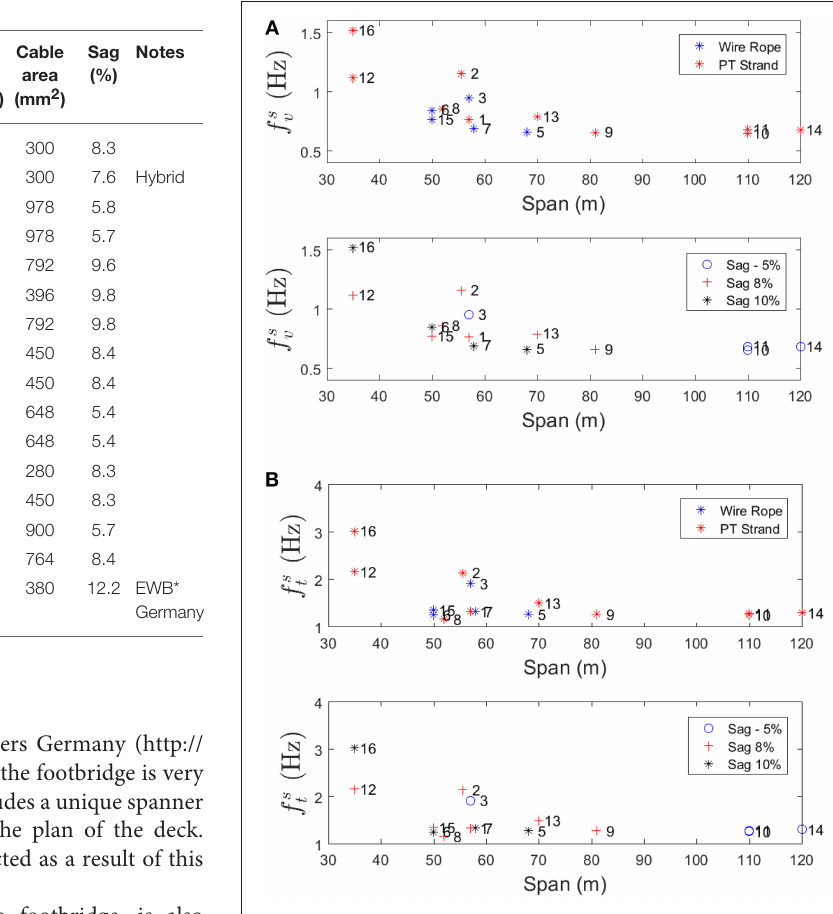
FIGURE 9 | Vertical (A) and torsional (B) symmetric frequencies of